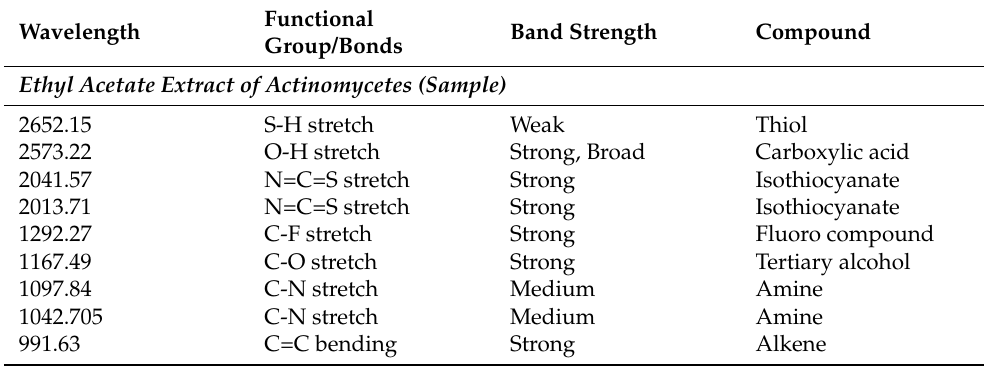
Table 3. FTIR analysis of compounds exhibiting their functional